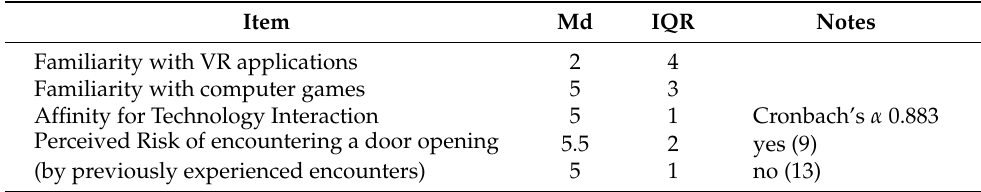
Table 1. Responses to the general questions (7-point Likert scales, 1—not familiar/low, 7—familiar/high). Item Md